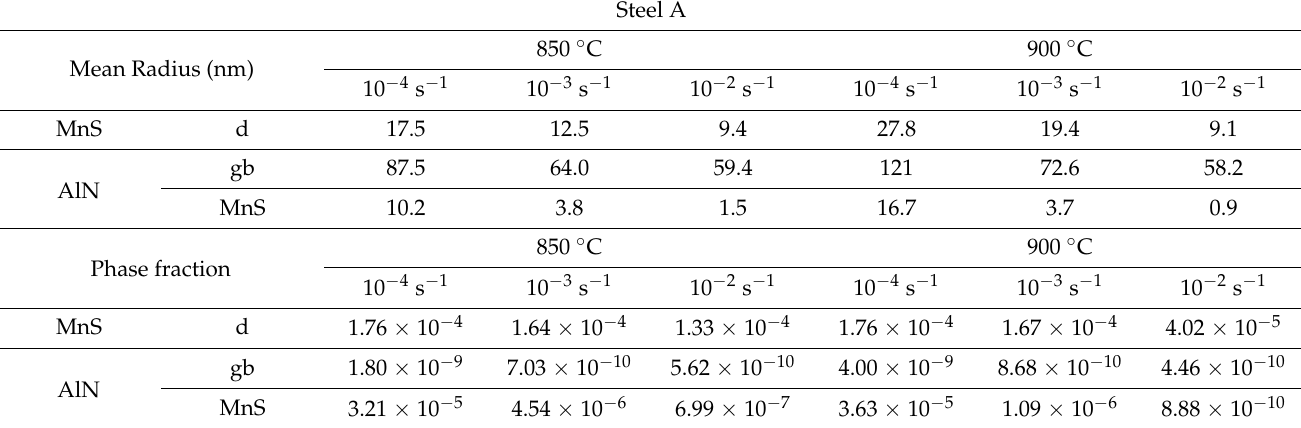
Table 2. Simulation results for the precipitation kinetics of steel